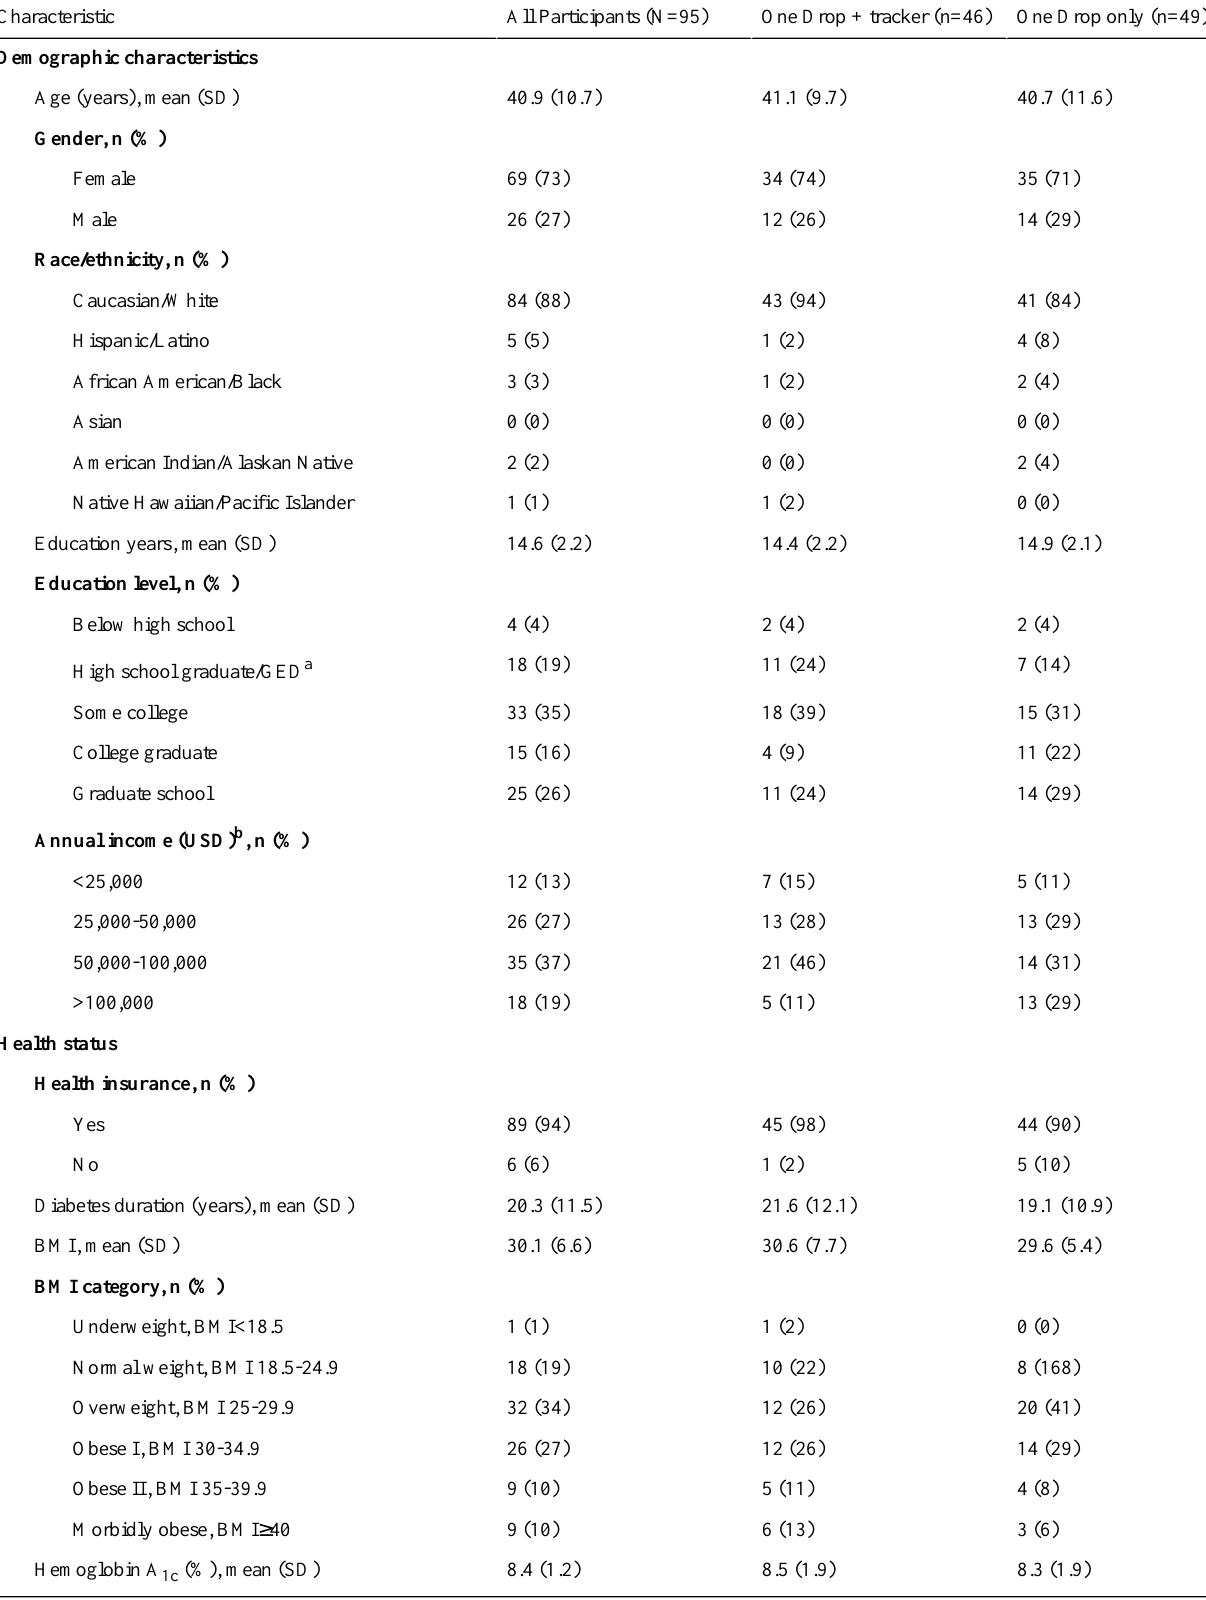
Table 1. Characteristics of intent-to-treat participants overall and by